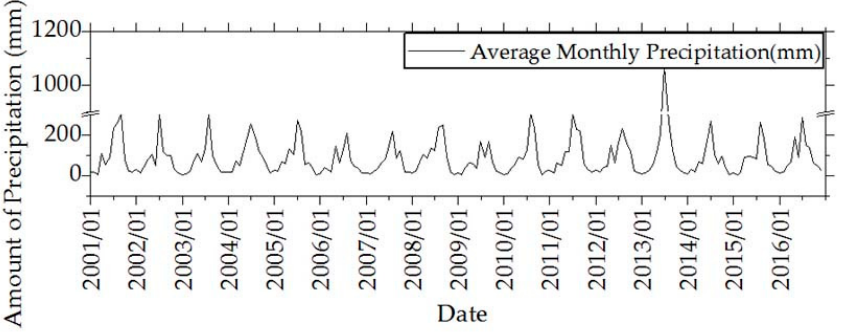
Figure 14. Average monthly precipitation (mm) at Dujiangyan Meterological Observatory from 2001 to 2016.